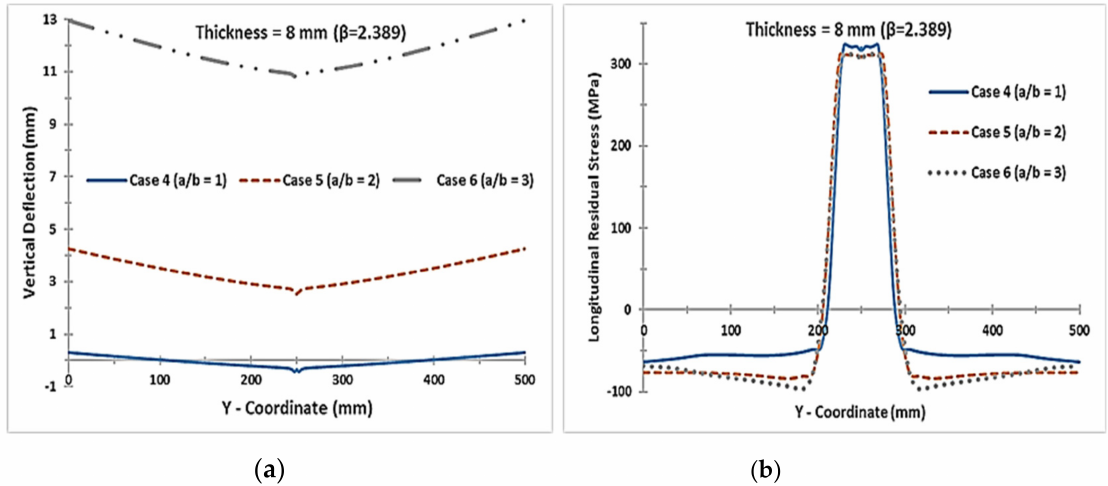
models. The plate with a / b = 3 has the same tensile residual stress of a / b = 2 with a slight increase in compressive residual stress near the heat-affected zone (HAZ).